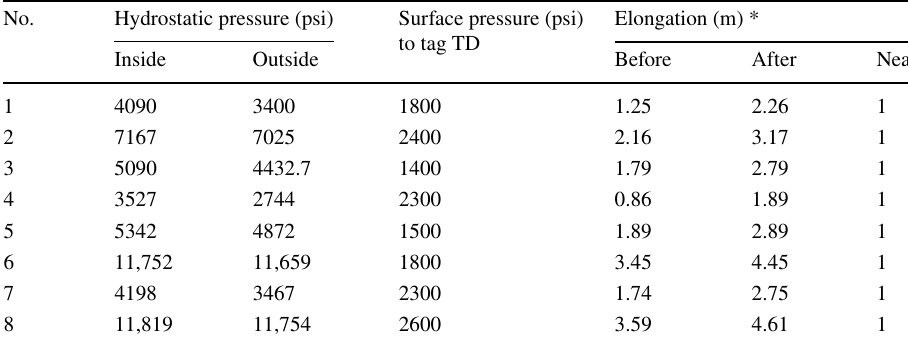
characteristics (Space out is one